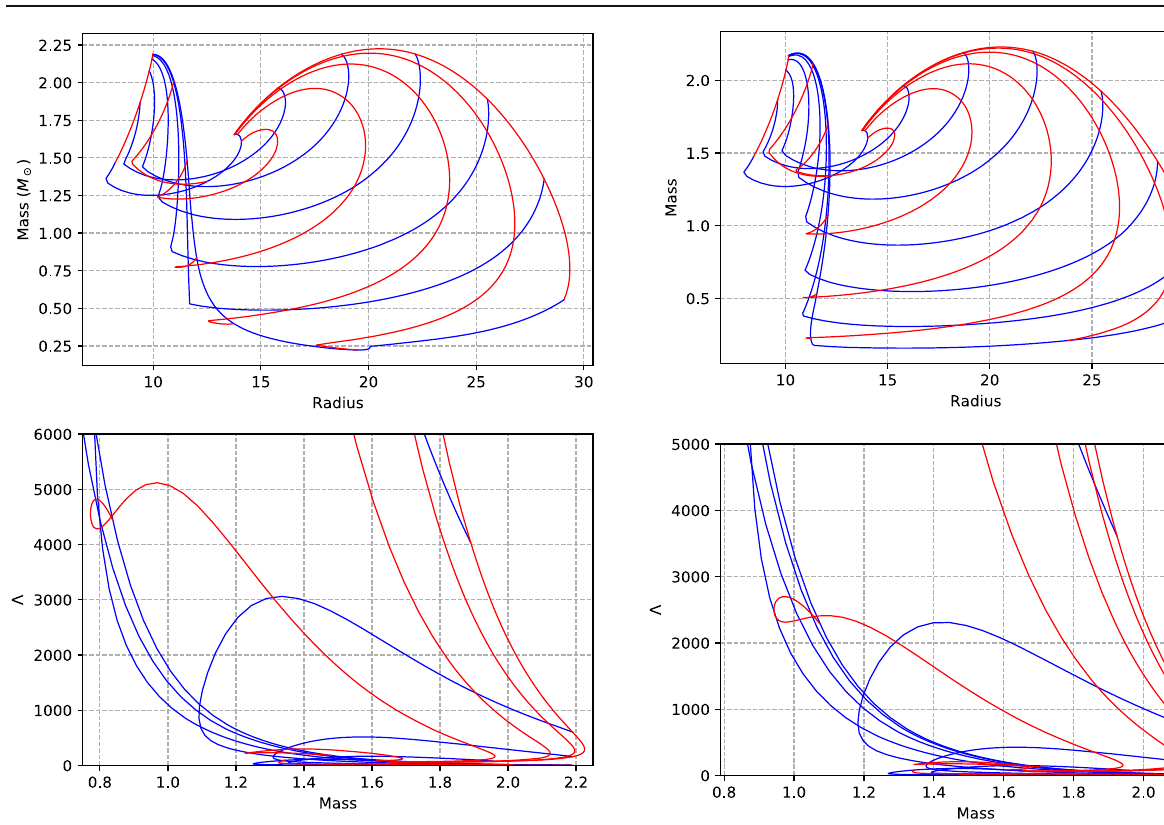
Fig. 11 Mass–radius (up) and TLN–mass (down) relations of the hybrid stars of type (IIIa) and (IIIb) in Fig. 1 for SKb EoS and for dark matter EoS with B = 0 . 055. The colouring means the same as that in Fig.